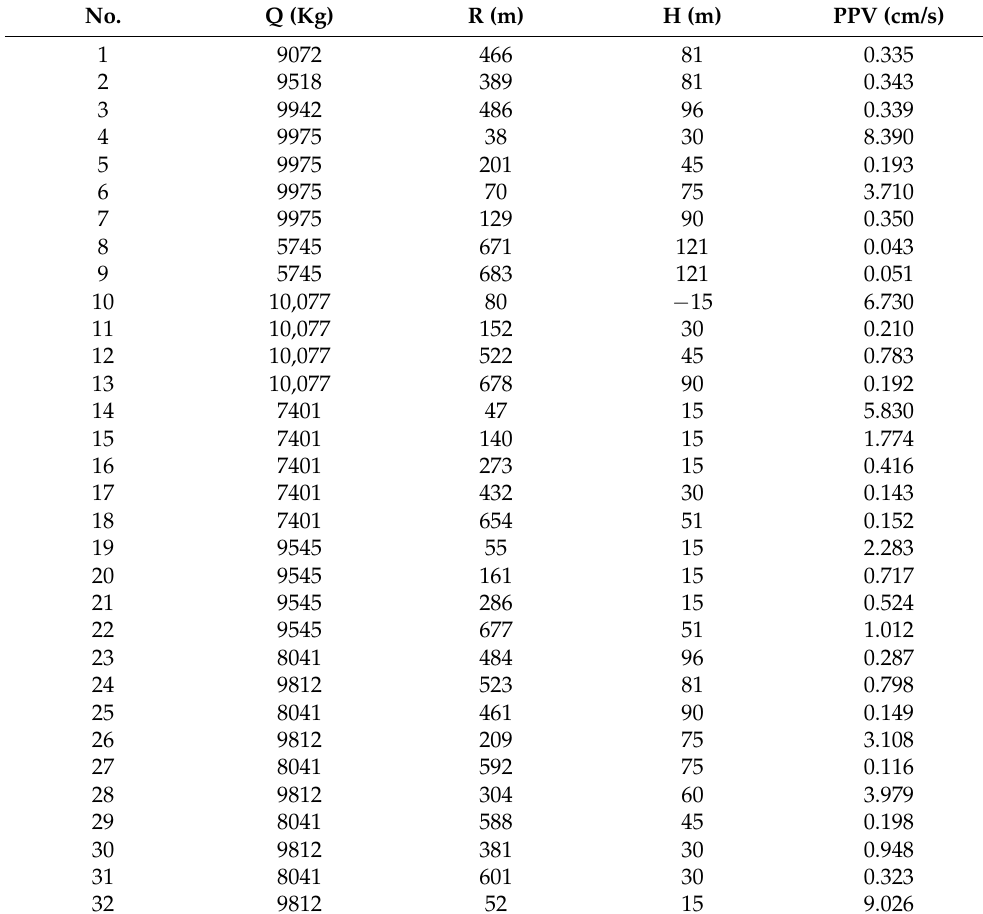
Table 1. Raw sample